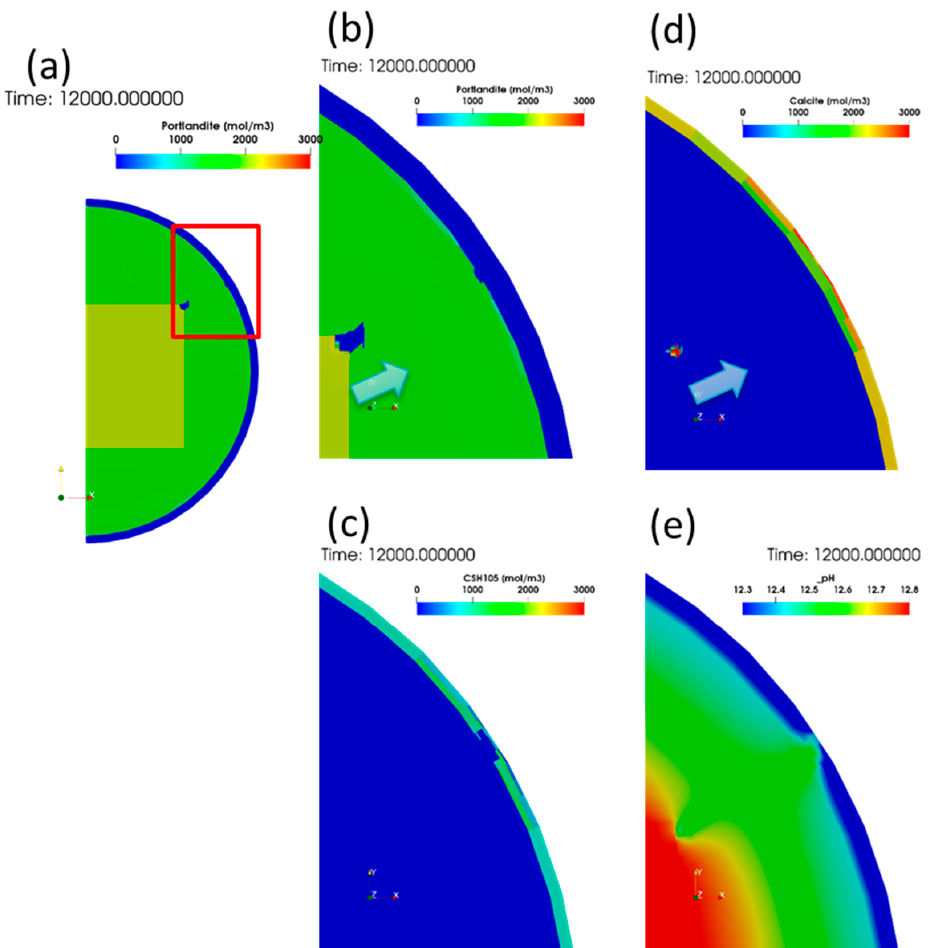
Figure 16. Portlandite ( a ) and its zoomed profile ( b ), at 12,000 years (2000 years after crack appearance), corresponding CSH165 ( c ) profile, calcite profile ( d ), and pH profile ( e ).